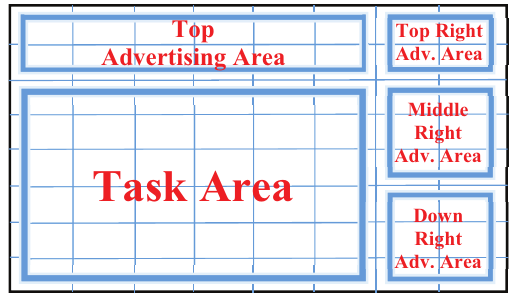
Figure 1. Task and advertising areas on the testing